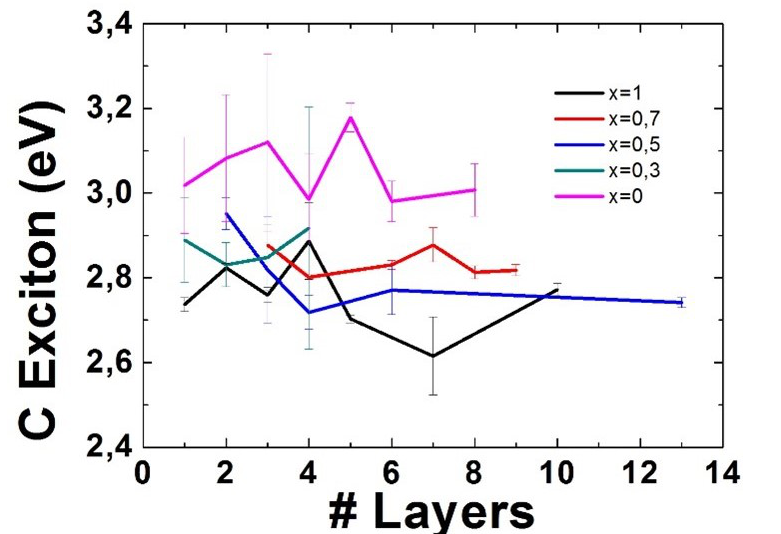
Figure 5. Position of the Gaussian fit corresponding to the C excitonic features for different number of layers and different alloying degrees. The error bars represent the error in the Gaussian fit for those layer numbers where only one measurement could be taken, and the standard deviation among measurements for those where several measurements could be taken.